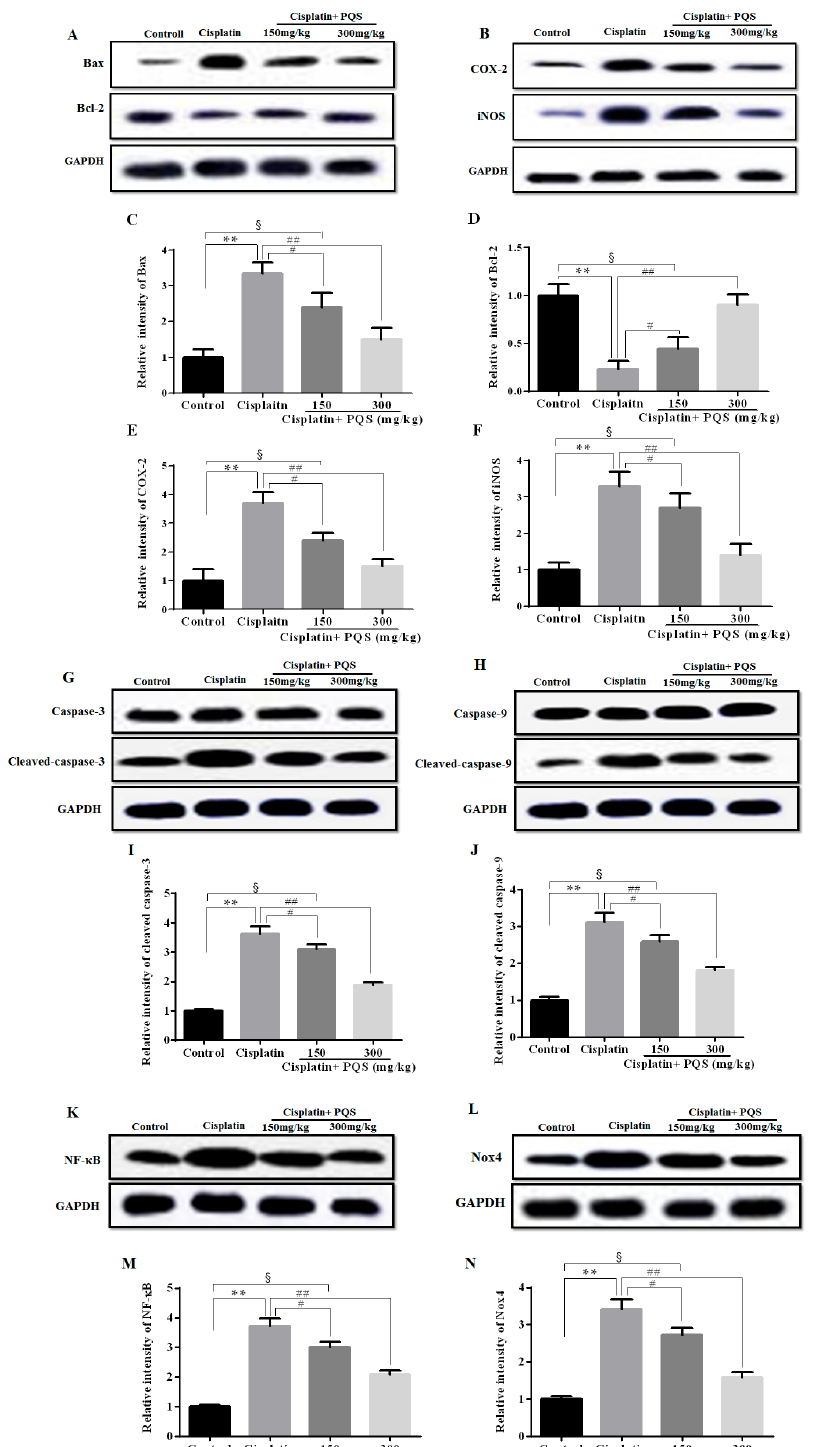
Figure 4. Effects of PQS on the protein expression of: Bax, Bcl-2 ( A ); COX-2, iNOS ( B ); cleaved Caspase-3 ( G ); cleaved Caspase-9 ( H ); NF- κ B ( K ); and Nox4 ( L ). Column chart show antibodies relative intensity of: Bax ( C ); Bcl-2 ( D ); COX-2 ( E ); iNOS ( F ); cleaved Caspase-3 ( I ); cleaved Caspase-9 ( J ); NF- κ B ( M ); and Nox4 ( N ). The protein expression was examined by Western blotting analysis in kidney tissues from control, cisplatin, cisplatin + PQS (150 mg/kg), and cisplatin + PQS (300 mg/kg). § p < 0.05, ** p < 0.01 vs. control group; # p < 0.05, ## p < 0.01 vs. cisplatin control group. Notes: glyceraldehyde-3-phosphate dehydrogenase, NAPDH; inhibitor of NF- κ B, I κ B; horseradish peroxidase, HRP.